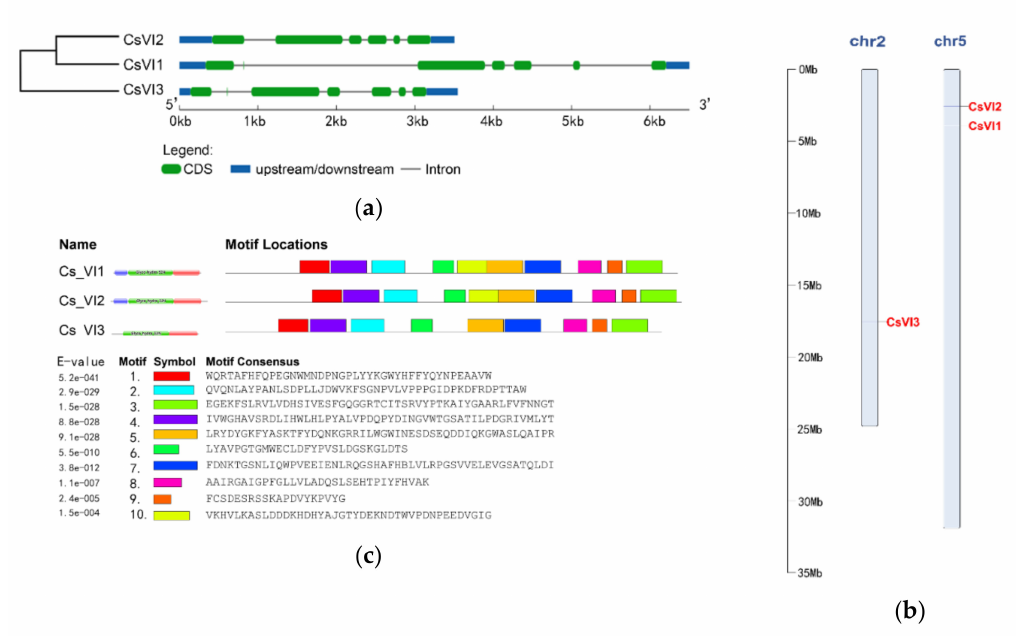
Figure 3. Gene structure ( a ), chromosomal localization ( b ), and conserved protein motif ( c ) of three putative CsVI